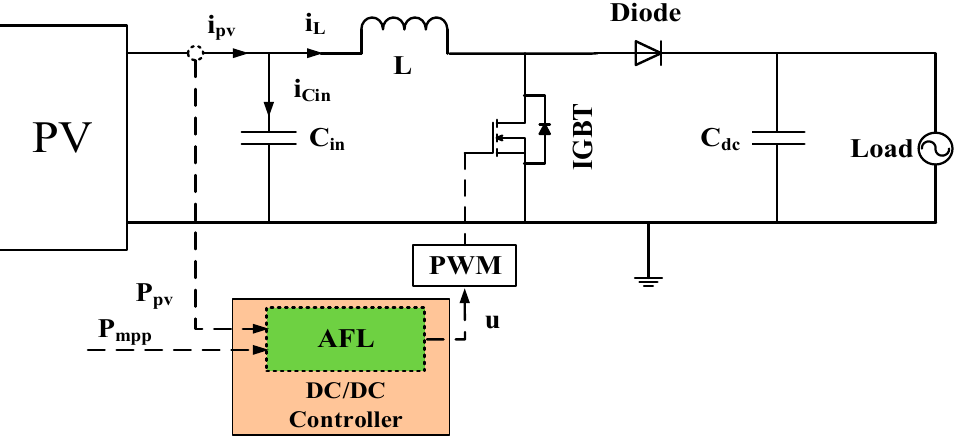
Figure 7. Topology of the DC/DC boost converter in PV systems